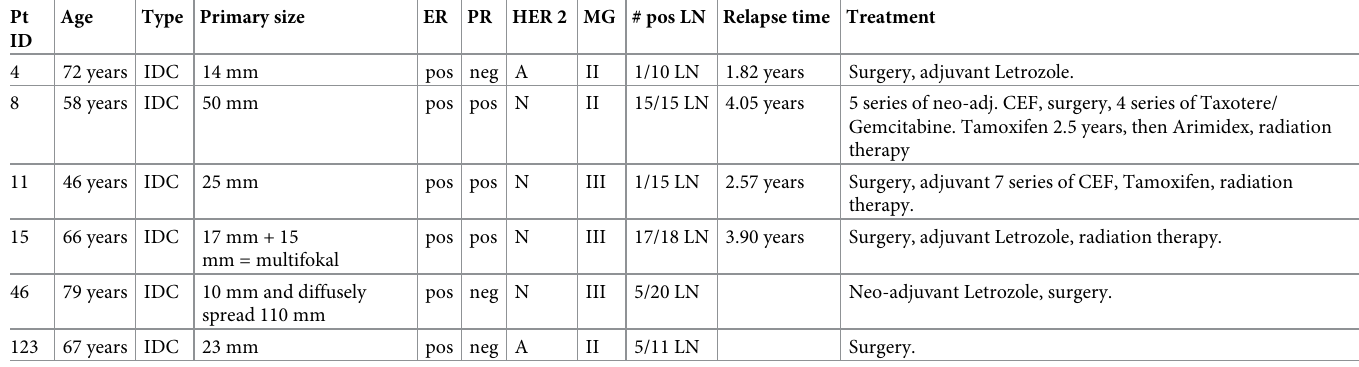
Table 1. Patient